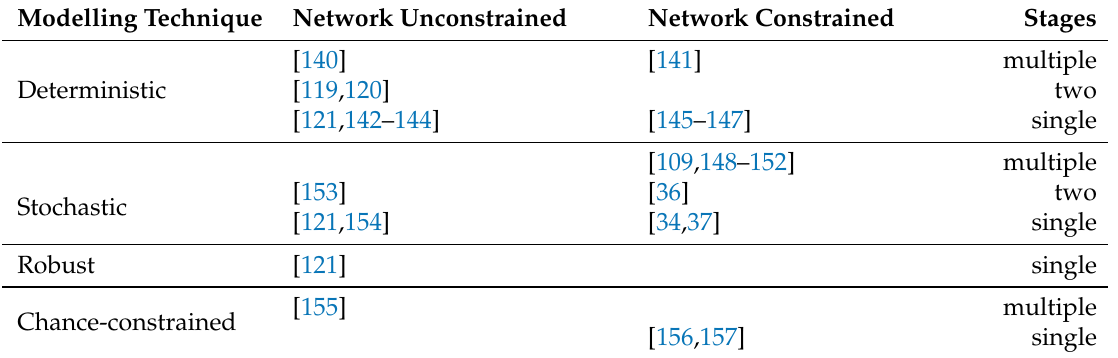
Table 5. Literature survey on the ESS investment planning models at the distribution